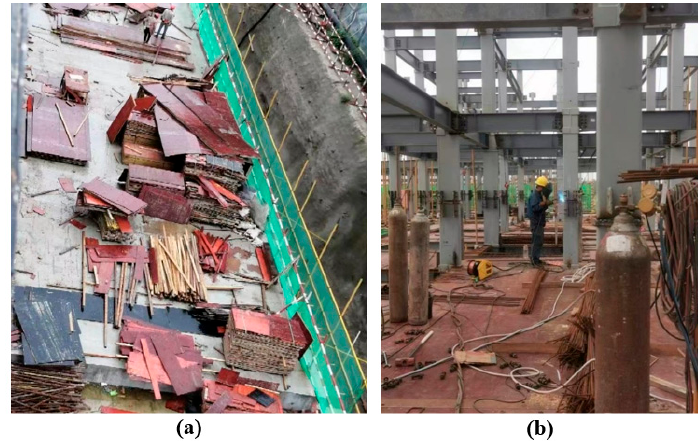
Figure 10. Monitoring scene during the main structure construction stage at ( a ) a flammable material stack area and ( b ) a fire-using work area.